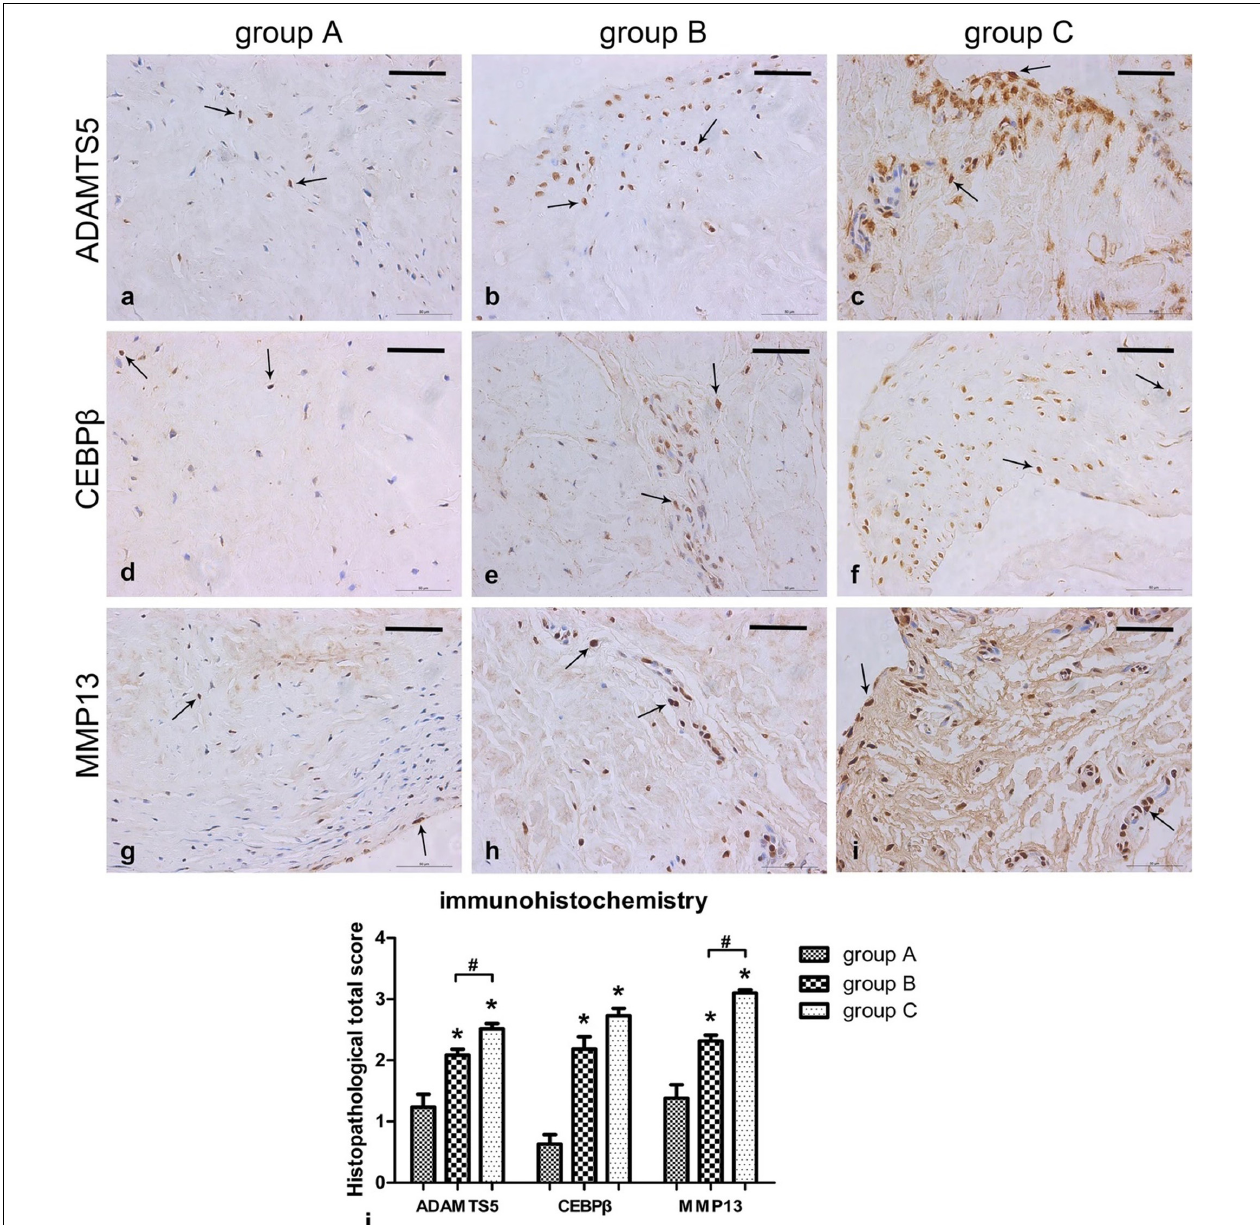
FIGURE 2 | Immunohistochemical results showing ADAMTS5, CEBP β , and MMP13 levels in the meniscus. (a–i) Sections were counterstained with haematoxylin, representative immunohistochemical positive cells are marked with arrows, Scalebar: 50 µ m. (j) Immunohistochemistry graph showing total histopathological score in group A (normal meniscus), group B (simple meniscal tear), and group C (meniscal tear with concomitant ACL tear), taken as the product of the specific reactivity (IR) and proportion of positive cells. The values are given as the mean and the standard error of mean. Within a given group, significant difference ( p < 0.05) compared with group A is denoted with (*). Significant differences ( p < 0.05) between group B and group C are marked with (#). Representative results from at least three samples in each group are shown. This figure was adapted permission from Long et al.